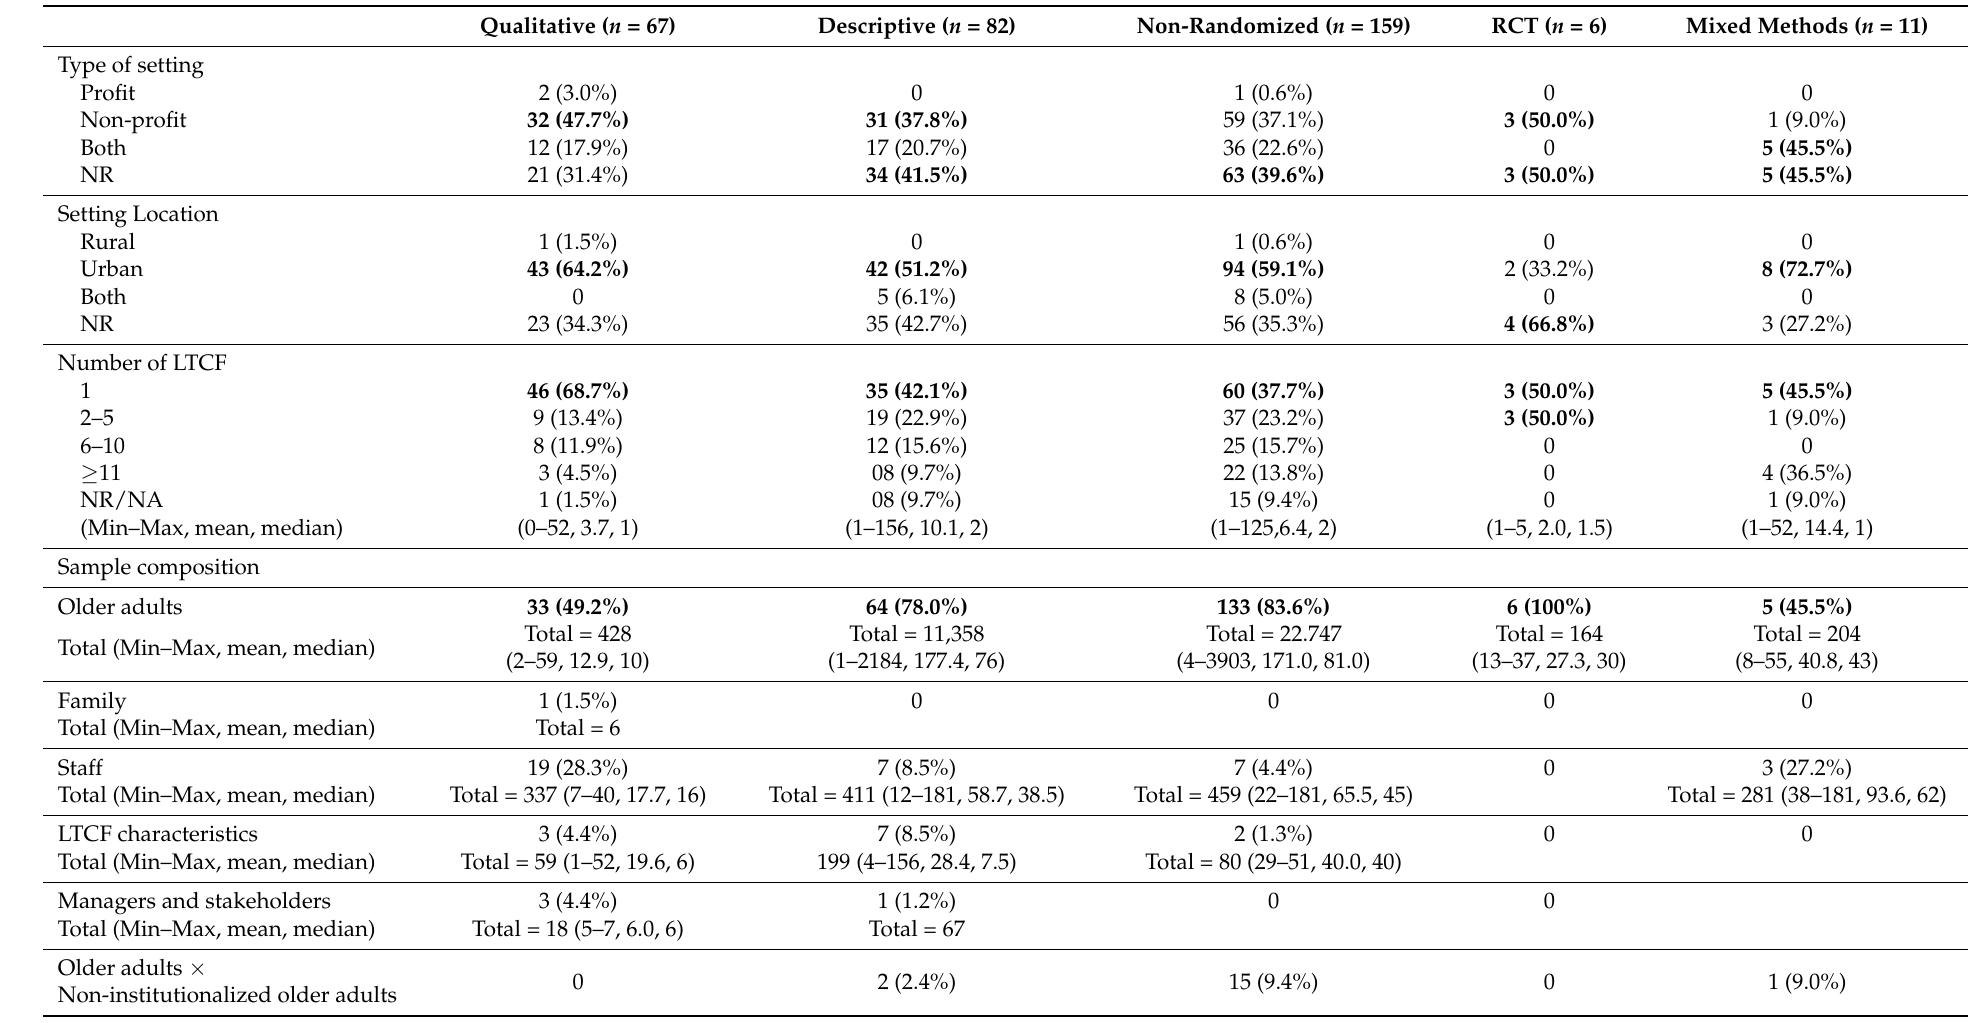
Table 2. Characteristics of the long-term care facilities (LTCFs) studied in the included papers from primary research conducted in Brazilian LTCFs published in scientific journals by the type of